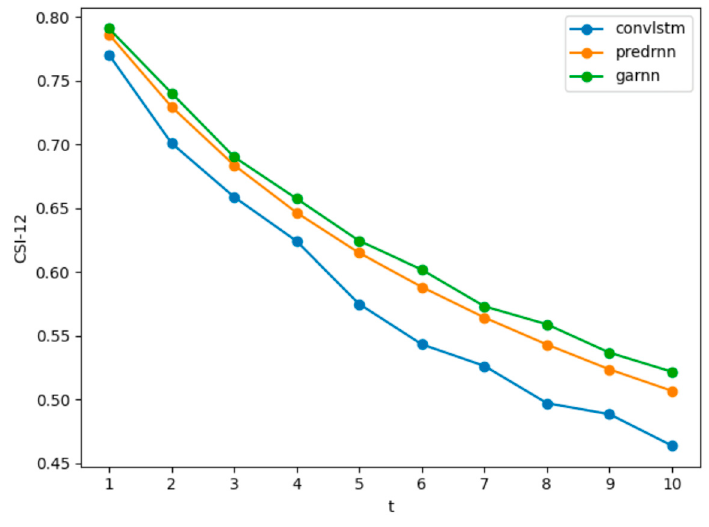
Figure 12. Frame-wise comparison of GARNN, ConvLSTM, and PredRNN at 12 dBZ threshold.